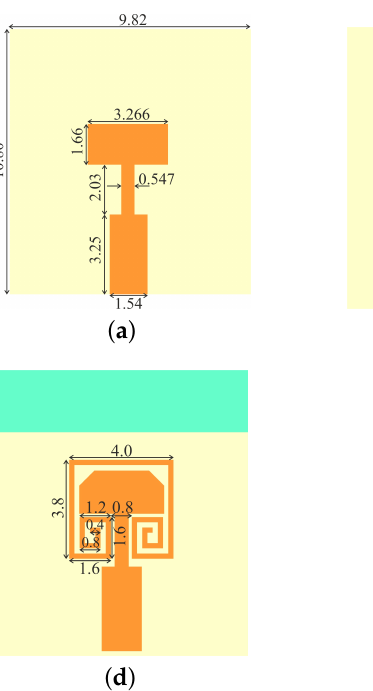
Figure 2. Layout of the antenna configurations (Units mm) ( a ) Reference model ( b ) Intermediate model ( c ) Intermediate model with partial ground ( d ) With parasitic